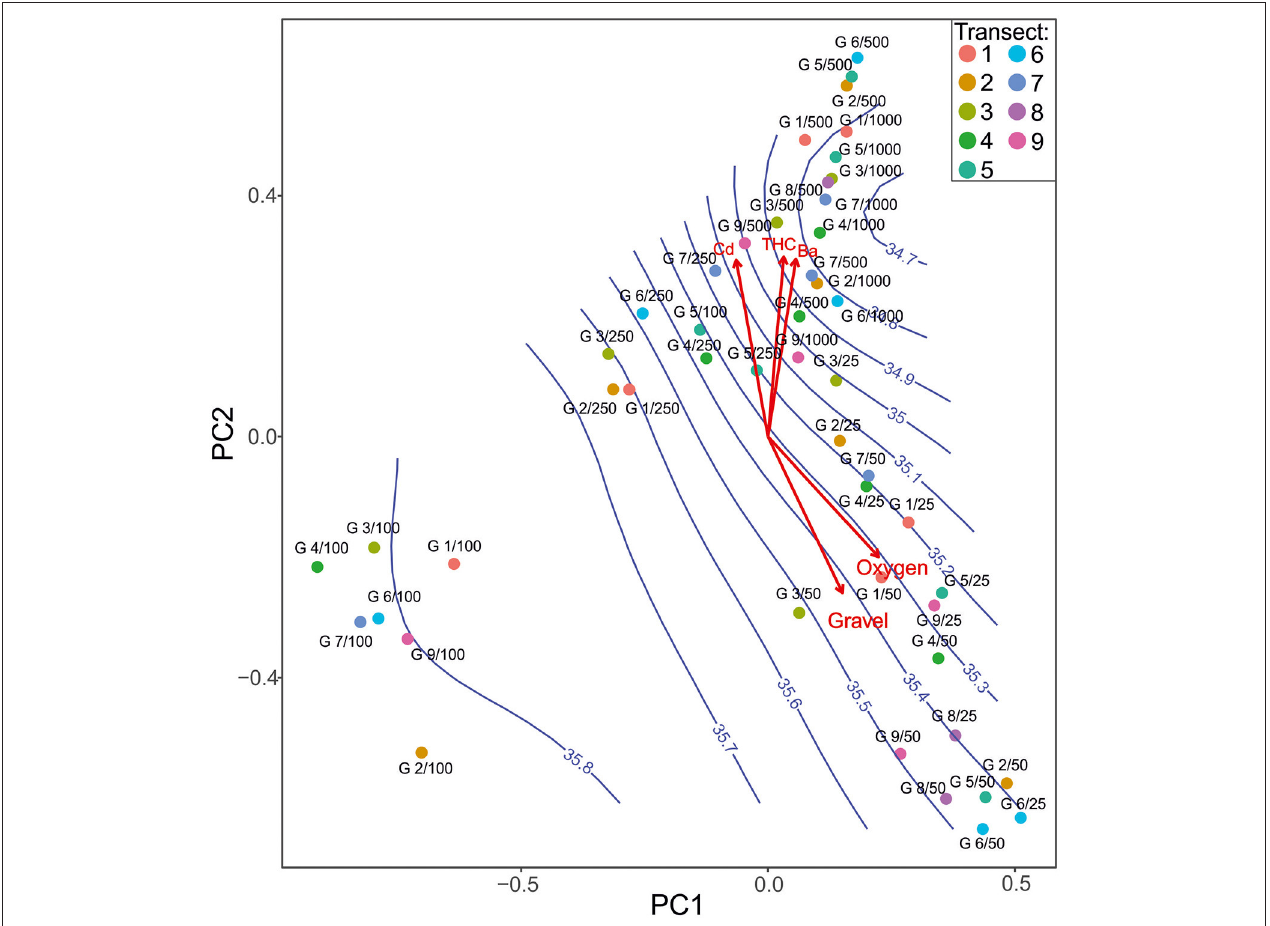
FIGURE 6 | Principal component analysis showing species composition differences in each sampling site according to environmental factors with sampling sites (points) and ranges of salinity (blue